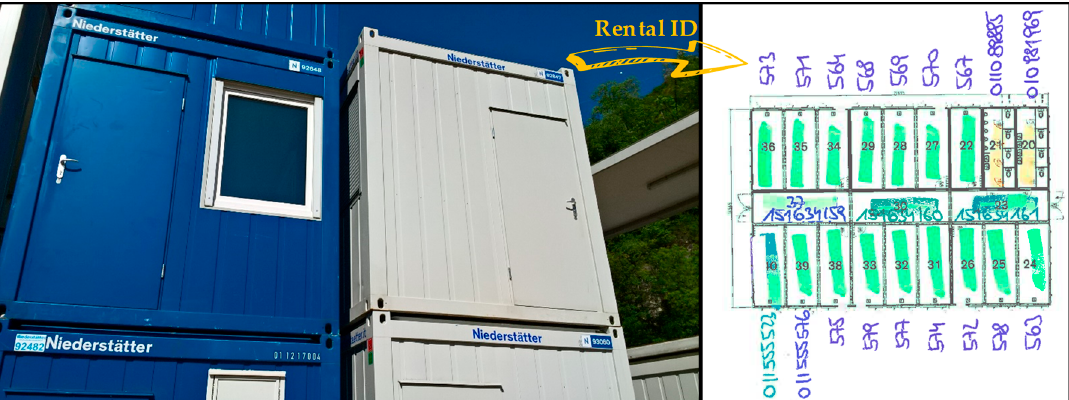
Figure 4. Manual assignment of rental IDs.